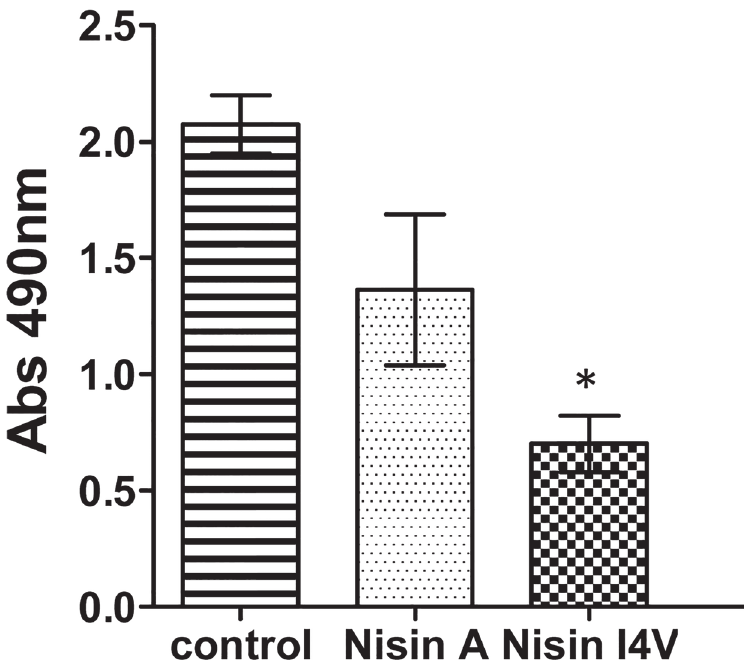
Fig 5. Colorimetric readings of biofilms. Viability of S. pseudintermedius DK729 following treatment with 16X MIC of nisin A and nisin I4V peptides and untreated control for 24 hrs as evaluated by the XTT (2,3-bis[2- methyloxy-4-nitro-5-sulfophenyl]-2H-tetrazolium-5-carboxanilide) assay measured using a microtiter plate reader. Asterisks indicate statistically significant differences (Student ’ s t-test) between peptides used at similar concentration ( * = p <